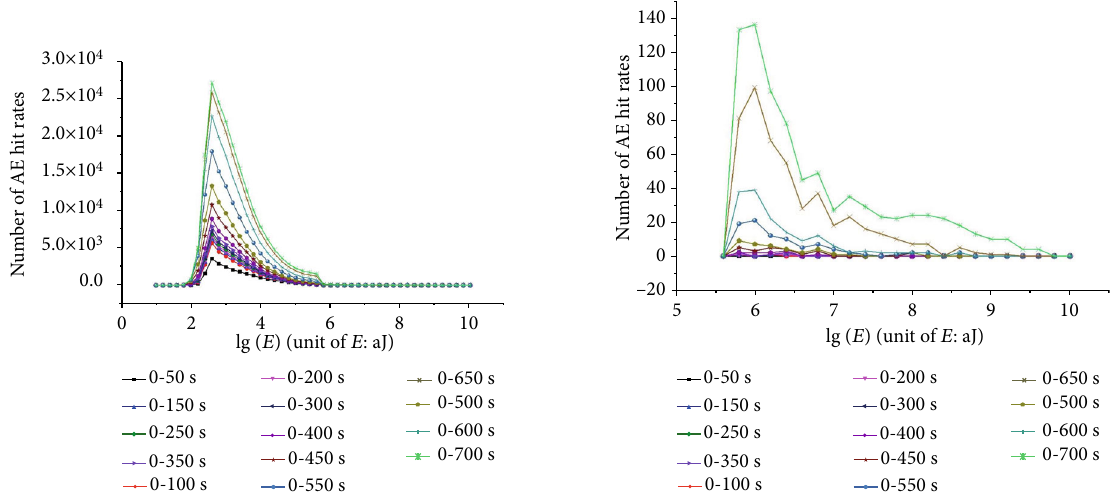
Figure 9: Energy distribution of AE hits during the experiment